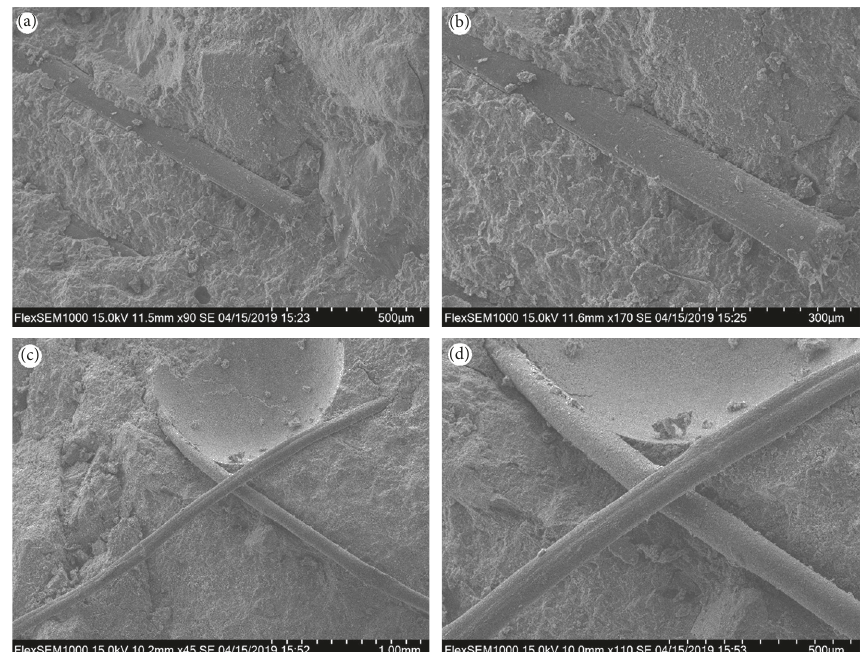
Figure 11: SEM pictures of P4 at 28-day. (a) Magnified 90 times. (b) Magnified 170 times. (c) Magnified 45 times. (d) Magnified 110